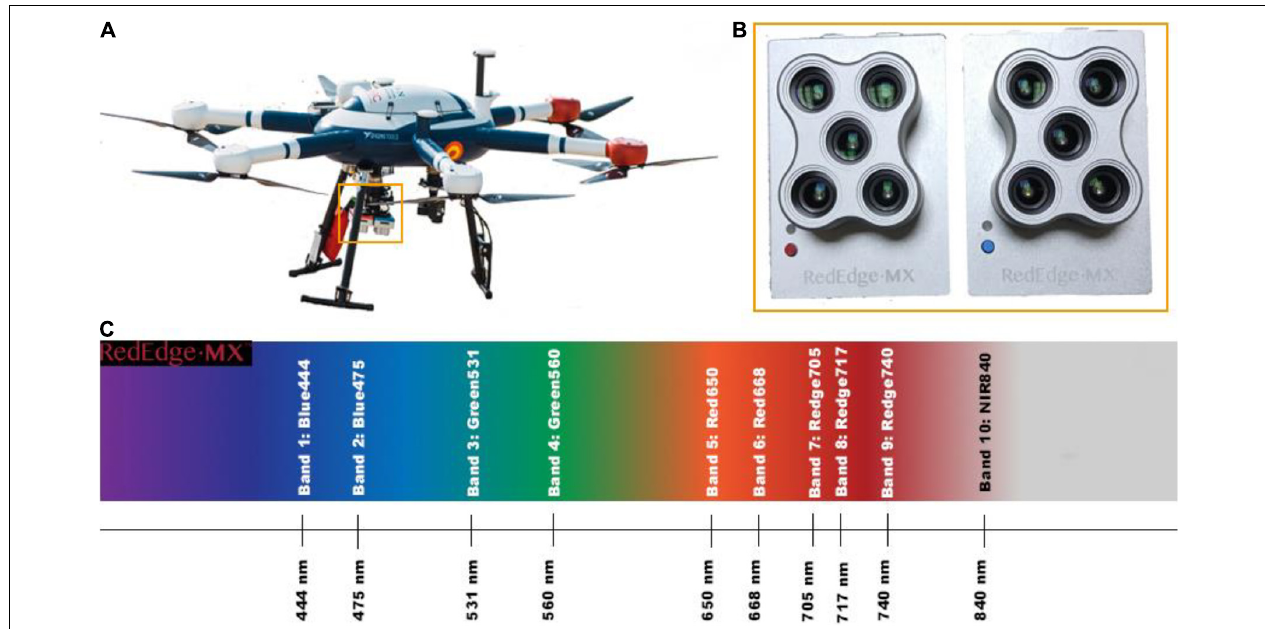
FIGURE 2 | (A) The UAV (Condor, Dronetools © ) equipped with the MicaSense RedEdge-MX dual multispectral camera (framed in yellow). (B) The ten bands dual multispectral camera (framed in yellow). (C) Representation of the spectrum from visible to non-visible light (range 400–900 nm). The bands of the multispectral camera are